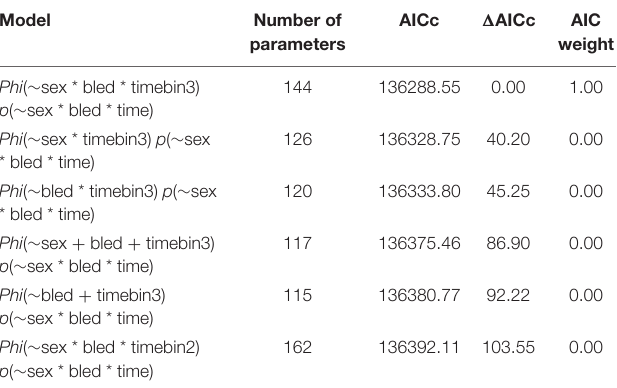
TABLE 3 | Statistics for the top 6 candidate models fit to the capture histories for horseshoe crabs tagged in the Delaware Bay population (Delaware Bay and coastal Delaware to Virginia, cf Figure 1 ) from 1999 to